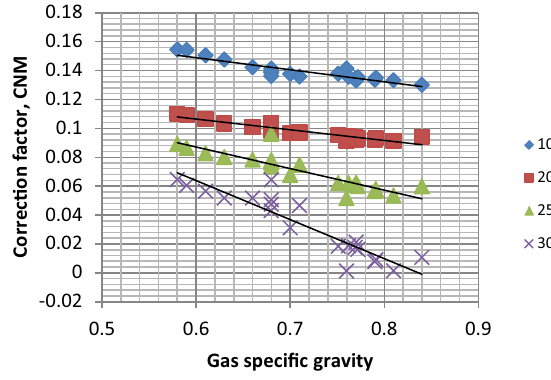
Fig. 7 Calculation of C NM at 220 (cid:3) F and different pressures